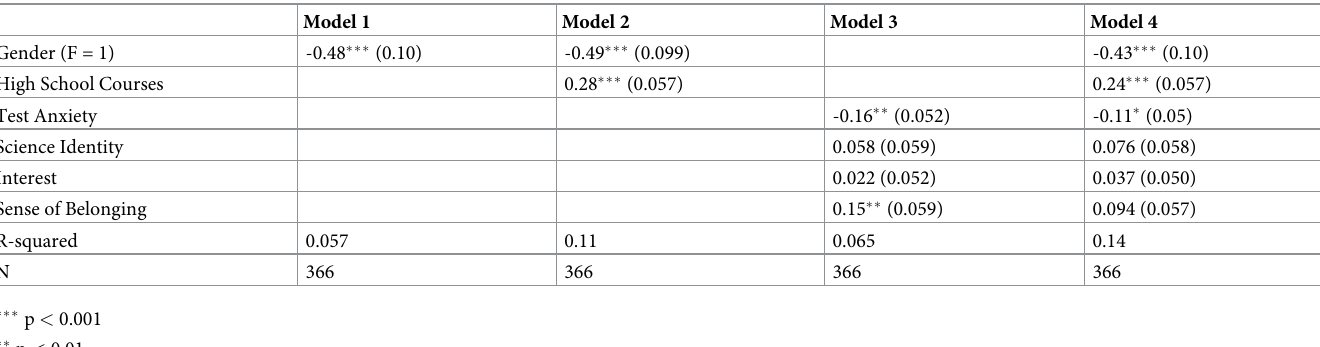
Table 4. Multivariable linear regression predicting the effects of gender, high school physics coursework, and social psychological factors on FMCE